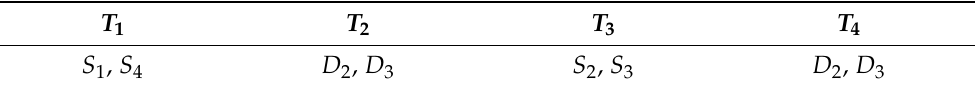
Table 6. Conduction of switches in different time intervals in DC2B